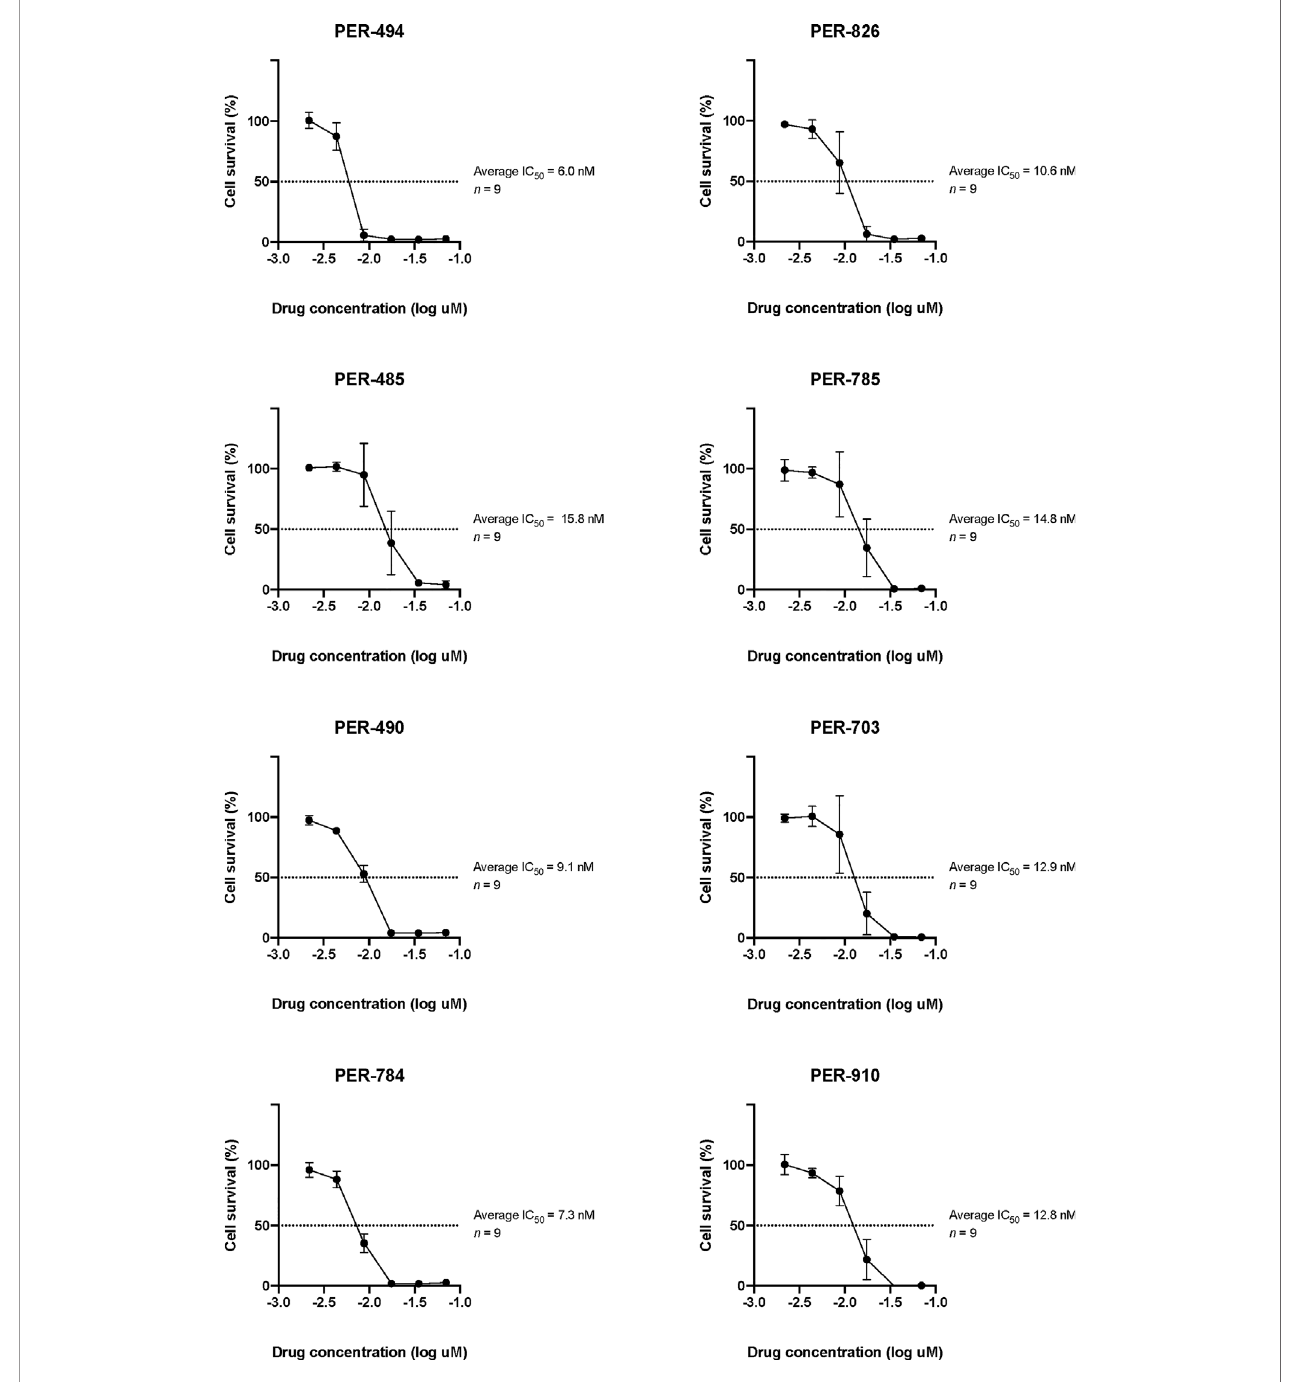
FIGURE 1 | Log dose-response analyses of car fi lzomib in PER cell lines derived from infants with KMT2A -rearranged acute lymphoblastic leukemia. The half maximum inhibitory concentrations (IC 50 ) are indicated. Data points are represented as the mean ± standard deviation of n = 9